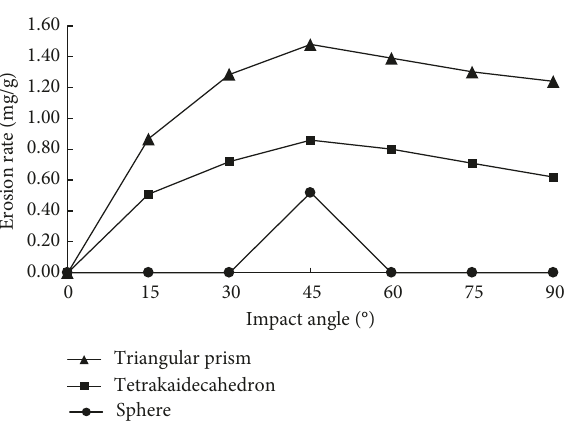
Figure 15: Effect of impact velocity on the erosion rate.